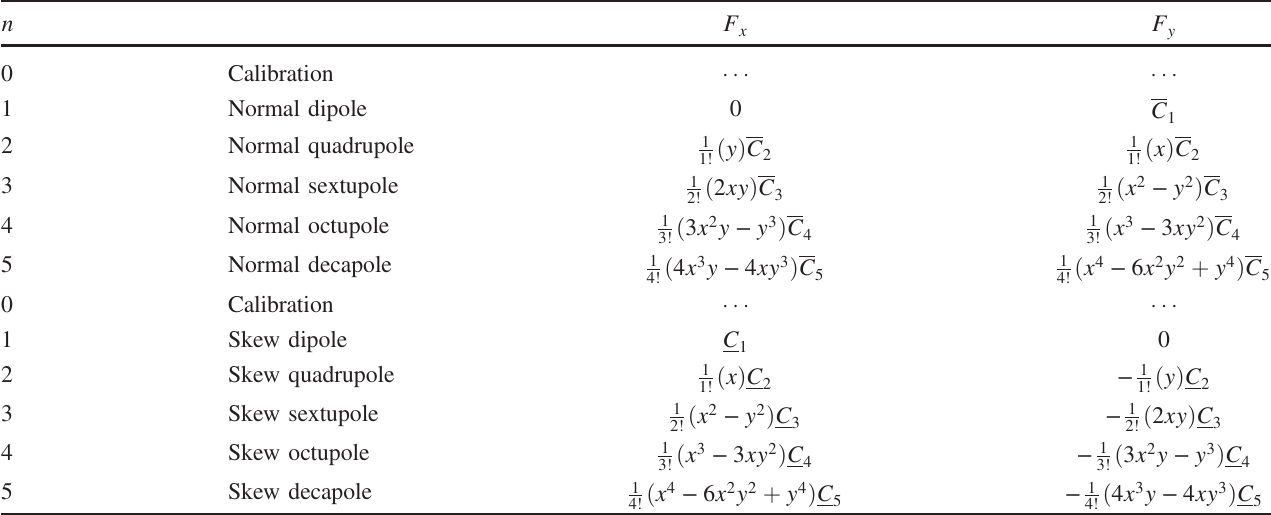
TABLE X. Horizontal and vertical components of pure normal and skew R-multipole magnets ’ field.